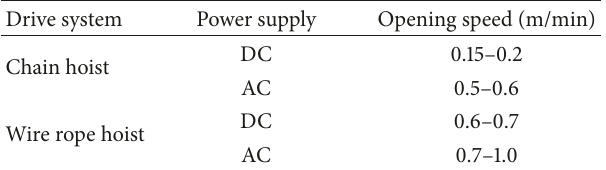
Figure 3: Longitudinal profile of the bottom outlet in the buttress dam. Table 2: Typical opening speeds of radial gates in